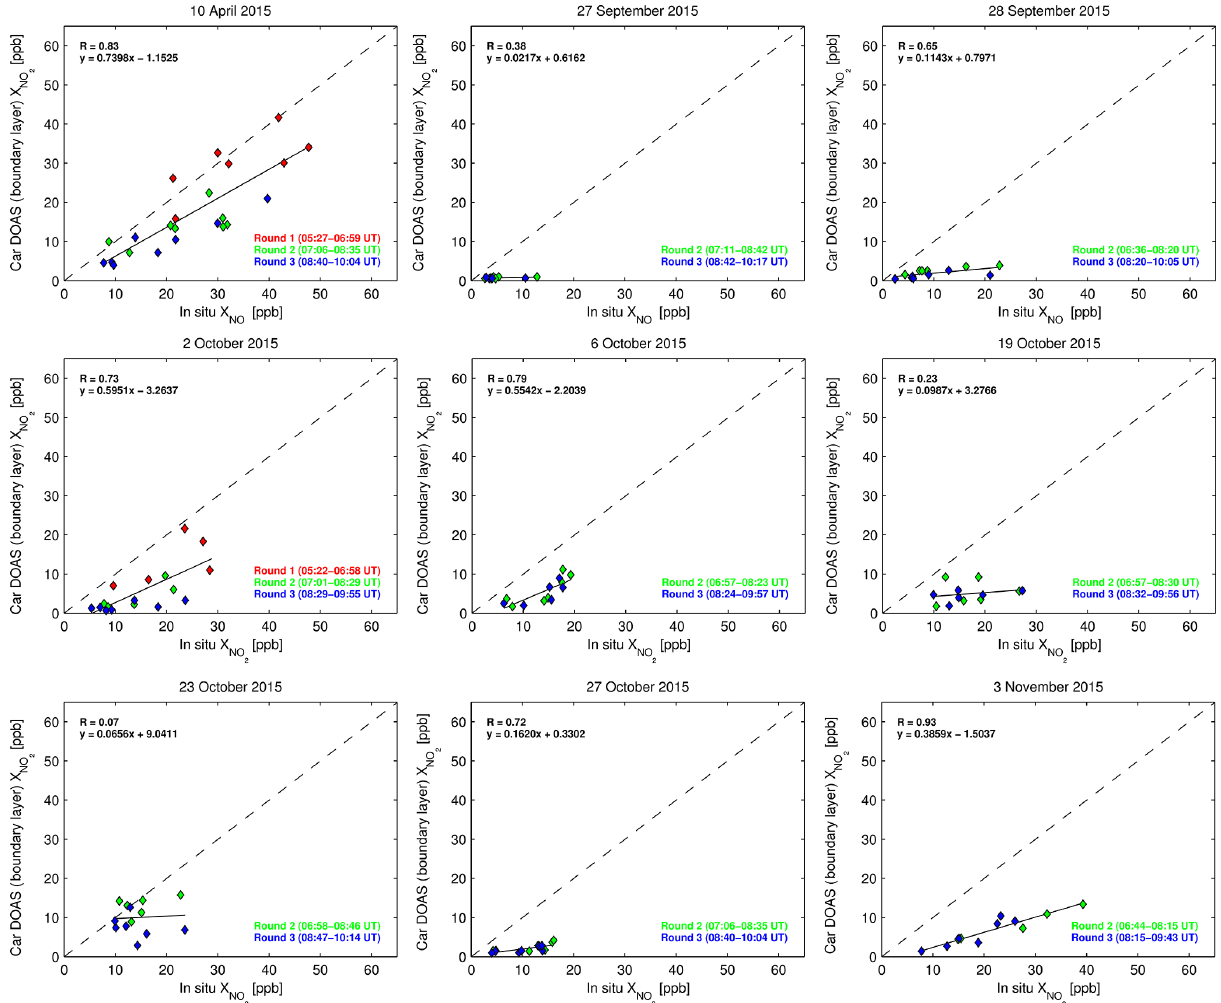
Figure 16. Comparison of boundary layer NO 2 mixing ratios estimated from car DOAS zenith-sky measurements with NO 2 mixing ratios obtained from in situ measurements on the nine days when measurements were performed. The dotted line represents the 1 : 1 relationship.